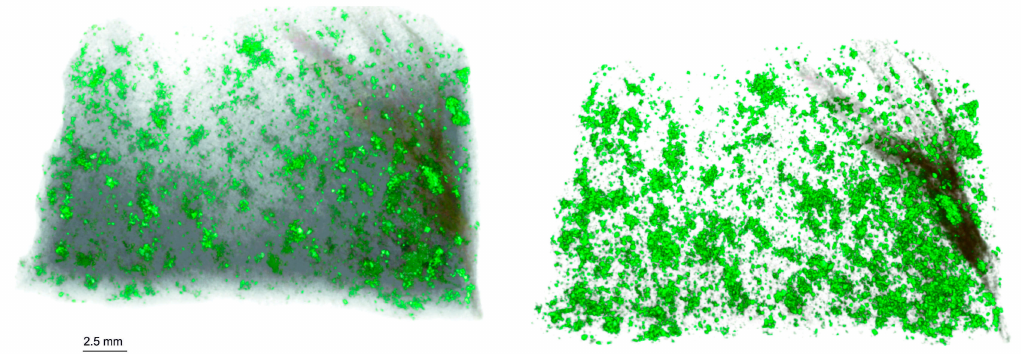
Figure 6. The distribution of copper minerals (green) in the quartz-calcite matrix (gray) in sandstone. Grain Size